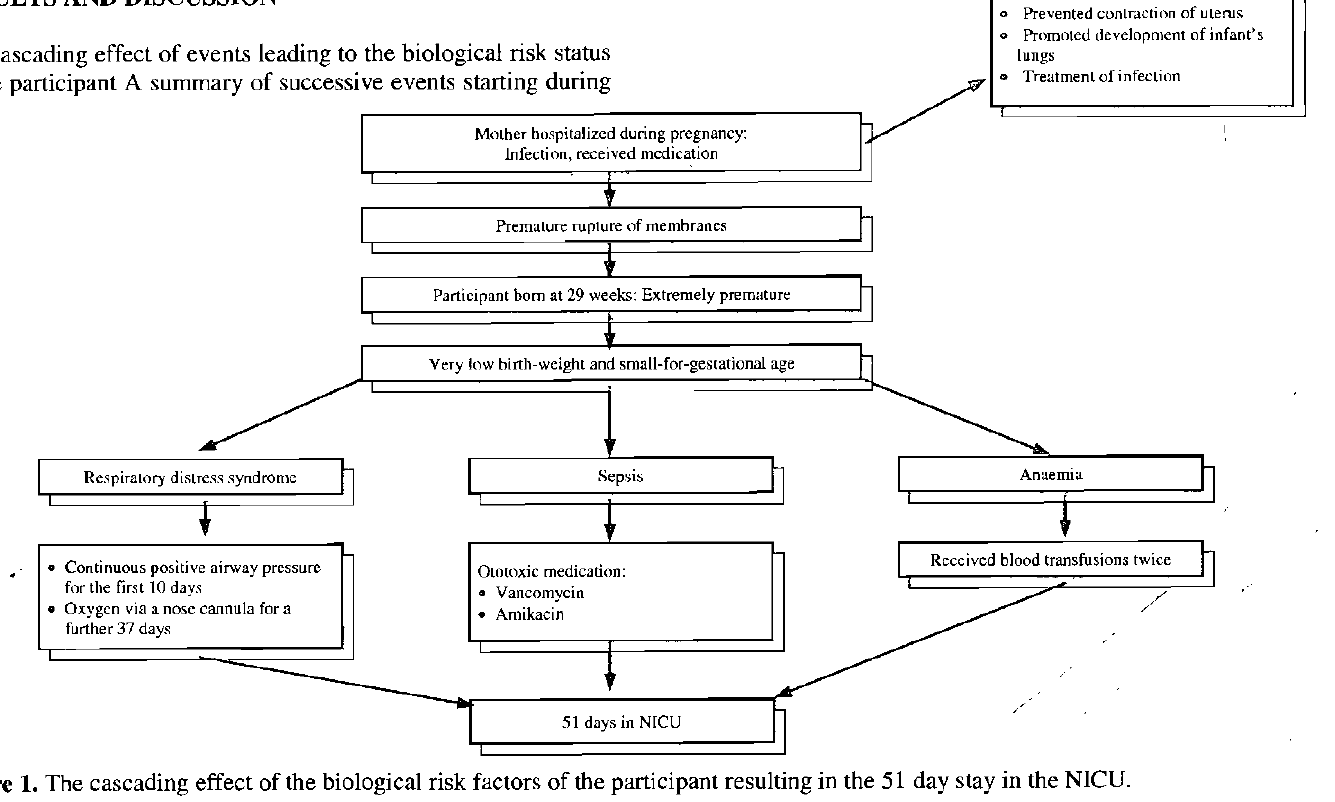
Figure 1. The cascading effect of the biological risk factors of the participant resulting in the 51 day stay in the NICU. Die Suid-Afrikaanse Tydskrif vir Kommunikasieafwykings, Vol. 52,